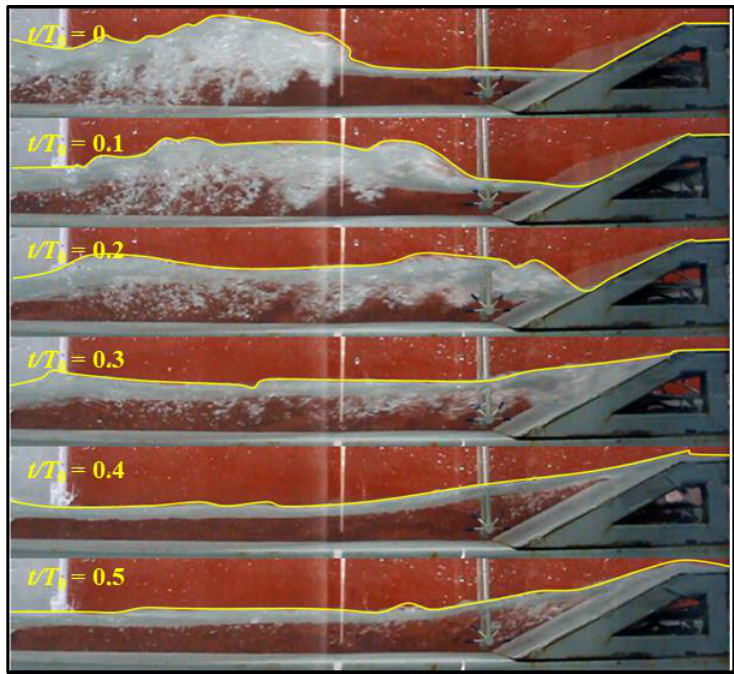
Figure 10. Wave propagation process for the sloped seawall on the reef flat for H 0 = 0.1 m, T 0 = 1.4 s, cot θ = 3, l = 1 m, and h r = 0.05 m.